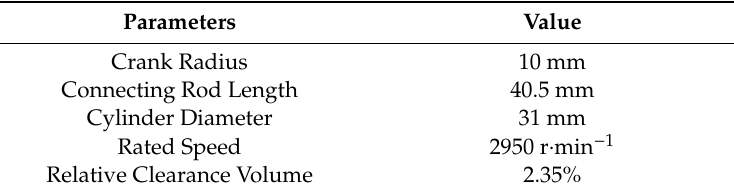
Figure 1. Schematic diagram of modified compressor. Table 1. The refrigerator compressor structural parameters.